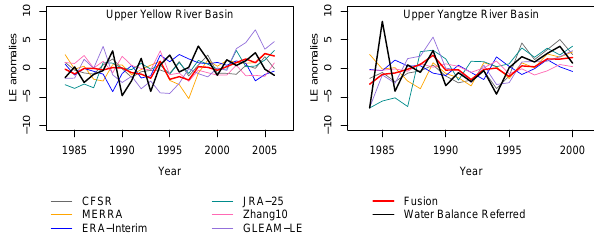
Figure 6. Anomalies of the annual basin average latent heat flux from multiple data sets and fused data with the water balance re- ferred value over the upper Yellow River and upper Yangtze River basins (units are Wm − 2